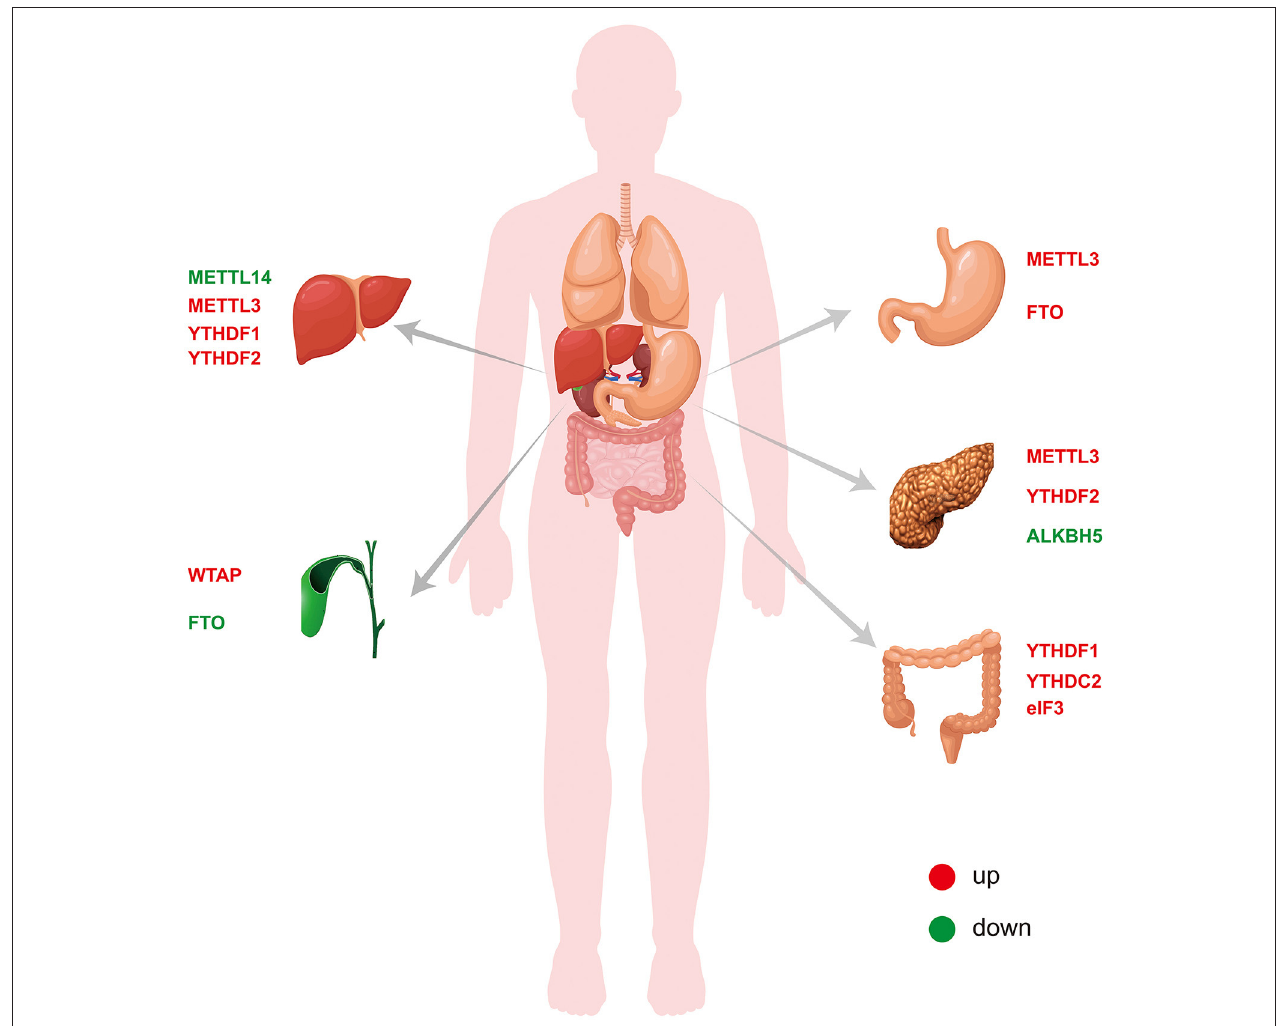
FIGURE 2 | Expression of m6A-related proteins in digestive system